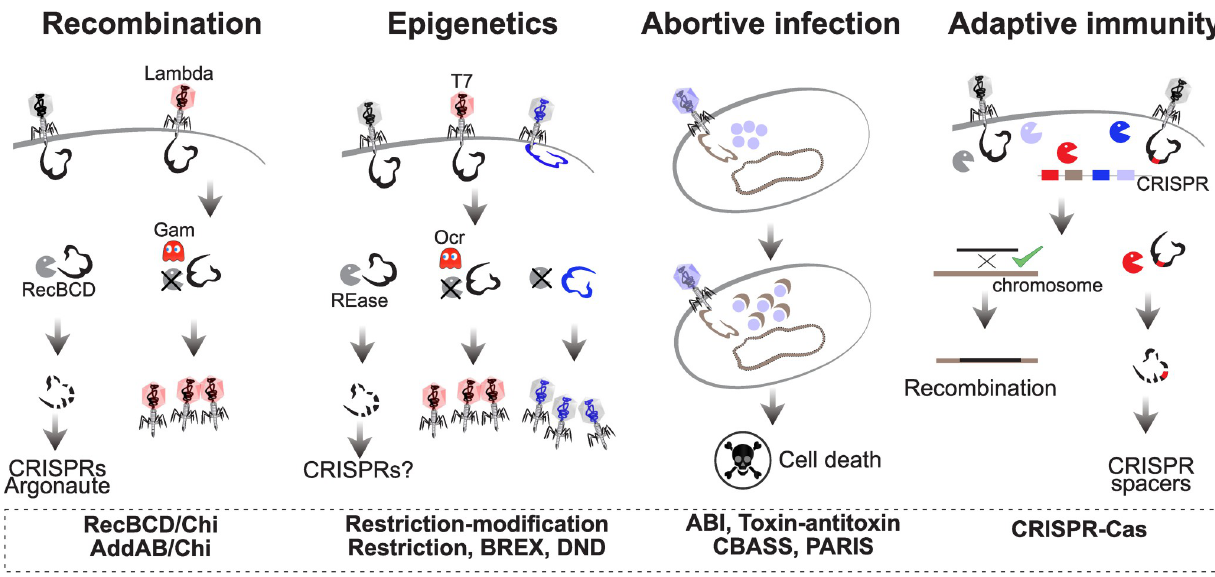
Fig 1. Examples of defense systems discussed in the text. Homologous recombination via the RecBCD pathway can defend from MGEs because RecBCD is a powerful exonuclease that degrades linear double-stranded DNA (but is inactivated by some phage encoded proteins, like Gam). Epigenetic modifications are the basis of many defense systems that can be counteracted by phage proteins, like Ocr in phage T7, or by epigenetic modification of phage DNA. Abortive infection is a costly defense strategy that induces cell growth arrest or death when a threat to the cell is detected. Adaptive immunity by CRISPR/Cas systems targets MGEs with specific DNA sequences, while allowing other exogenous DNA to remain in the cell and eventually recombine with the chromosome. CRISPR/Cas, clustered regularly interspaced short palindromic repeats/CRISPR associated protein; MGE, mobile genetic